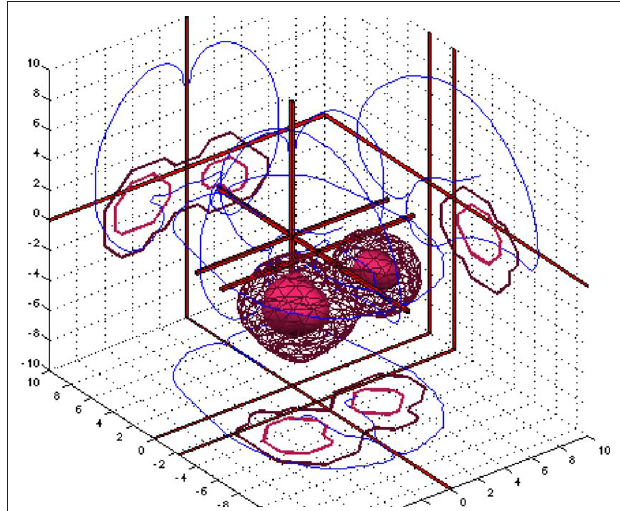
FIGURE 5 | Corner cube visualization on the Web page of the Brede Database with results from a non-negative matrix factorization of experiments in the